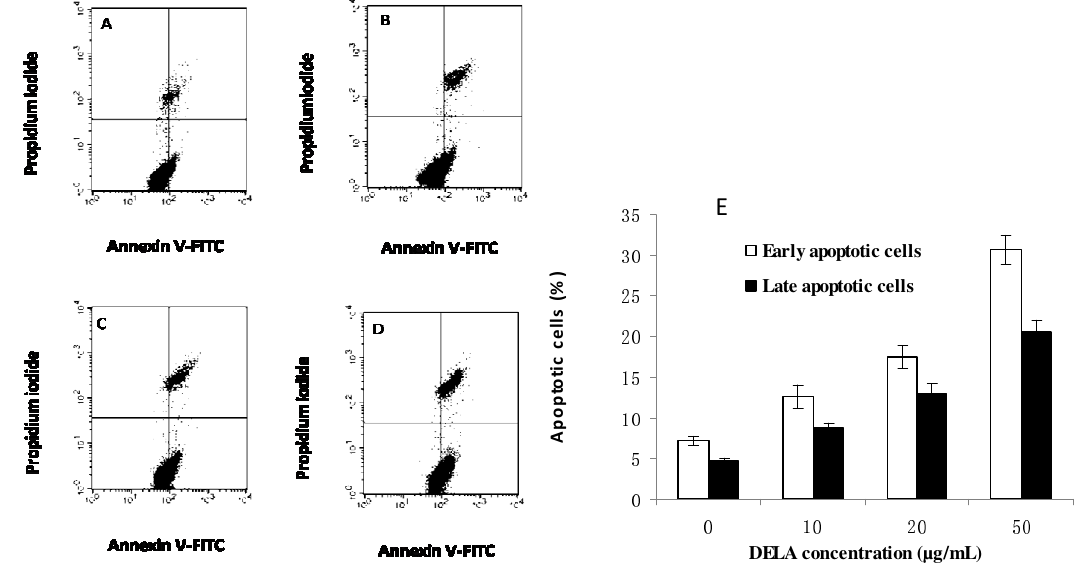
Figure 2. Annexin V/PI double-staining assay of murine sarcoma S180 cells treated with ( A ) 0, ( B ) 10, ( C ) 20, and ( D ) 50 µg/mL DELA. The Y-axis represents the PI-labelled population, whereas the X-axis represents the FITC-labelled Annexin V positive cells. The lower left portion of the fluorocytogram (An−, PI−) shows normal cells, whereas the lower right portion of the fluorocytogram (An+, PI−) shows early apoptotic cells. The upper right portion of the fluorocytogram (An+, PI+) shows late apoptotic cells. ( E ) The apoptotic rates of murine sarcoma S180 cells induced by DELA.